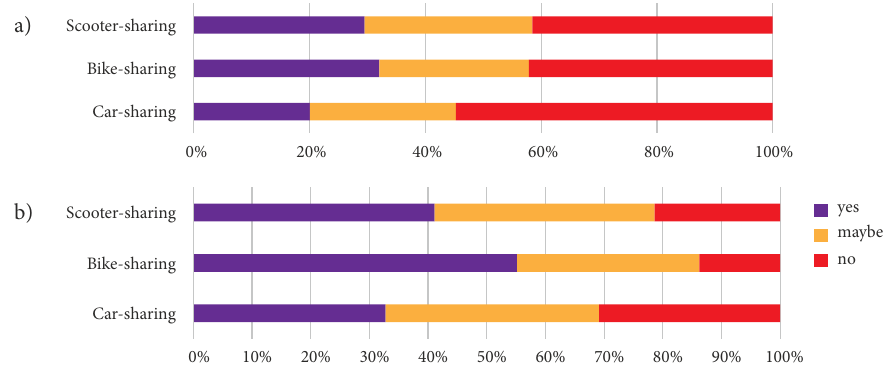
Figure 7. Distribution of respondents’ answers to the question on whether they would use the CS system if it appeared next month at the resort, by type of sharing mode, 2019–2020: a – residents of Birštonas; b – tourists of